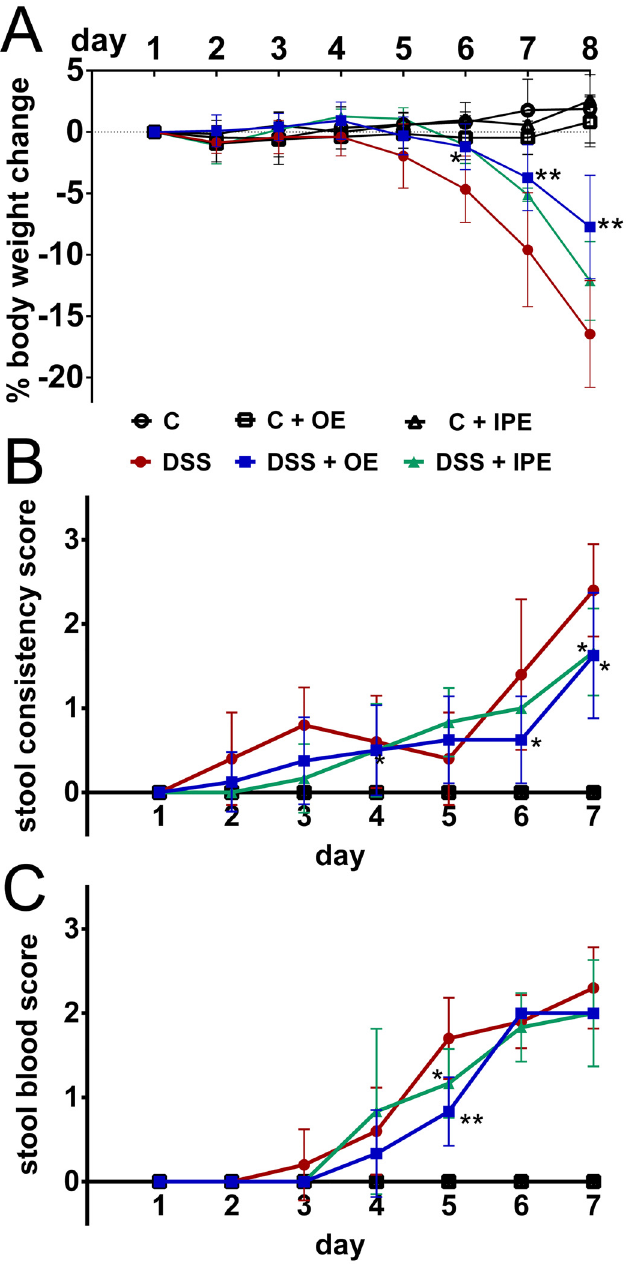
Fig 1. Effect of enoxaparin during acute colitis. (A) Daily body weight changes during colitis induction in C57BL/6 mice with and without enoxaparin compared to healthy control. Stool samples collected from mice were scored for (B) consistency and the presence of (C) occult blood on a daily basis during experiment. Results are expressed as mean ± SD of n = 3 – 14 mice. * p < 0.05 and ** p < 0.01. Control, C; control with oral enoxaparin, C+OE; control with intaperitoneal injection of enoxaparin, C+IPE; untreated colitis, DSS; colitis with oral enoxaparin, DSS+OE; colitis with intraperitoneal injection of enoxaparin, DSS+IPE.